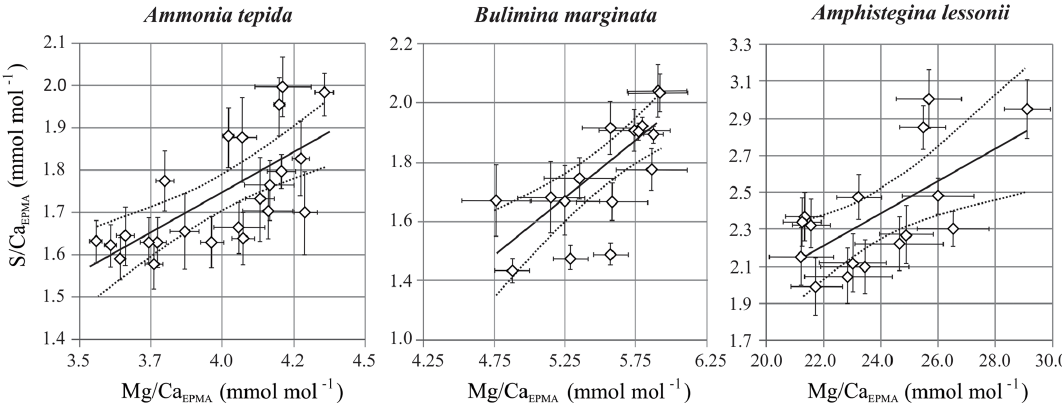
Figure 6. S / Ca EPMA versus Mg / Ca EPMA values ± SE of the EPMA transect maps of different species. Every symbol represents the average S / Ca EPMA and Mg / Ca EPMA of a single transect map, which are positively correlated for Ammonia tepida ( n = 24; S / Ca EPMA = 0 . 38 · Mg / Ca EPMA + 0 . 28 with R 2 = 0 . 47; p < 0 . 0005), Bulimina marginata ( n = 16; S / Ca EPMA = 0 . 43 · Mg / Ca EPMA − 0 . 18 with R 2 = 0 . 82; p < 0 . 0005) and Amphistegina lessonii ( n = 16; S / Ca EPMA = 0 . 089 · Mg / Ca EPMA + 0 . 26 with R 2 = 0 . 42; p < 0 . 0025). The location of the transects can be found in Table S1 and Figs. S1–S3. Note that the confidence interval (95%) is indicated with dotted lines. Data are semiquantitative and therefore expressed as E/ Ca EPMA , since calibration is performed against matrix unmatched mineral standards.